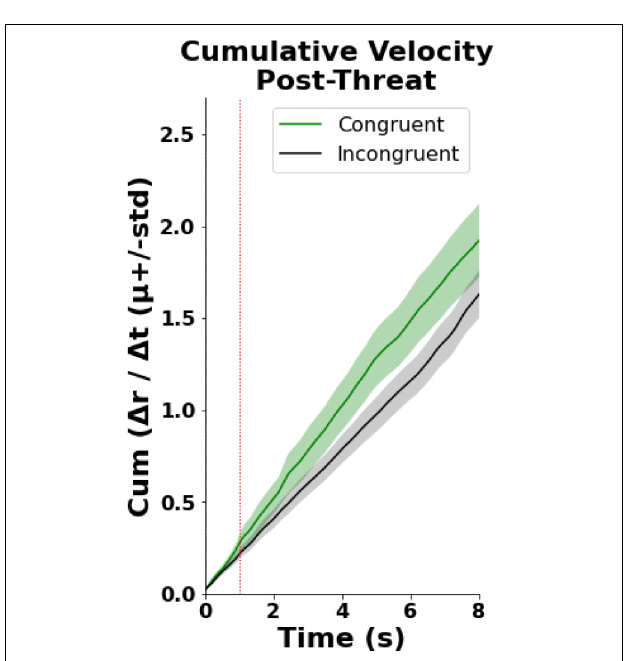
FIGURE 4 | Hand withdrawal results. T0 indicates the time when the knife appeared while the dashed red line shows the time when the knife stabbed the hand (time =